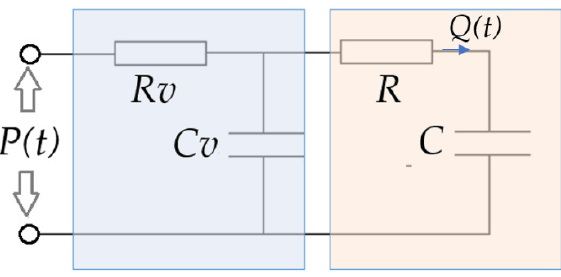
17 of 34 Figure 12. Application outlook on android phone: ( a ) login page, ( b ) database page, and ( c ) ventila- tor interfacing page. 3.7. Ventilator Model Prior to the test with the lung simulator, we have conducted a mathematic model for the mechanical ventilator. Graph pf pressure, flow, and volume from the model are then used for a reference graph. Figure 13 depicts the ventilator model [21]. For a negligent ventilator compliance, Cv , the ventilator model can be approximately described by the following two first-order differential equations: 𝑃(𝑡) = (𝑅 + 𝑅𝑣)𝐶 (cid:3031)(cid:3043) (cid:3276) (cid:3031)(cid:3047) + 𝑝 (cid:3028) (𝑡) , (2) 𝑃(𝑡) = 𝑄(𝑡)(𝑅 + 𝑅𝑣) + (cid:2869) (cid:3004) (cid:1516) 𝑄(𝑡)𝑑𝑡 , (3) where p ( t ) is the pressure source of the ventilator (mbar), Q ( t ) is the airflow (liter per mi- nute–lpm), R is the lung resistance (mbar/L/s), Rv is the ventilator related resistance, C is the lung compliance (mL/mbar), and 𝑝 (cid:3028) (𝑡) represents the airway pressure. The first-order differential Equations (2) and (3) can be solved for 𝑝